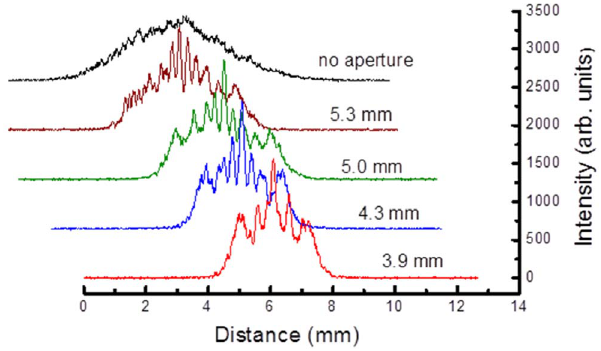
Figure 2. Beam profiles incident on the objective when apertures of different diameters are placed in the beam path.